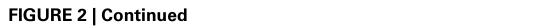
FIGURE 2 | Continued Characterization of neural units exhibiting pulse tracking